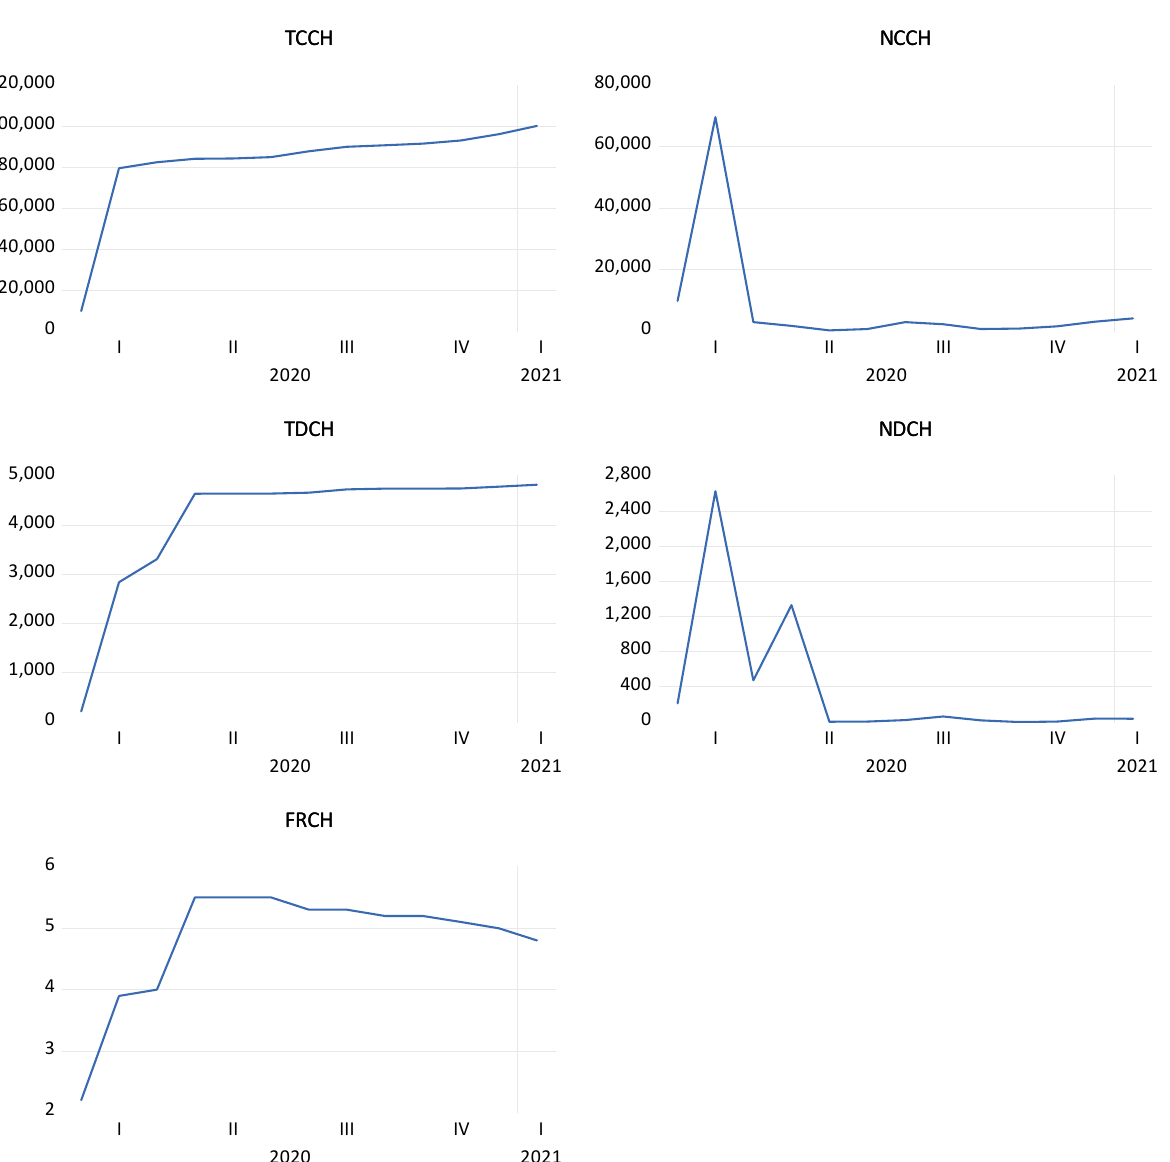
Figure A3. Source: compiled by the authors based on World Health Organization Coronavirus Disease 2019 (COVID-19) situation reports and the Our World in Data Coronavirus Pandemic (COVID-19) (Roser et al. 2020) database. Note: I = 1st quarter, II—2nd quarter, III—3rd quarter, IV—4th quarter. For TCCHt, NCCHt, TDCHt, NDCHt, and FRCHt, see Table 1.